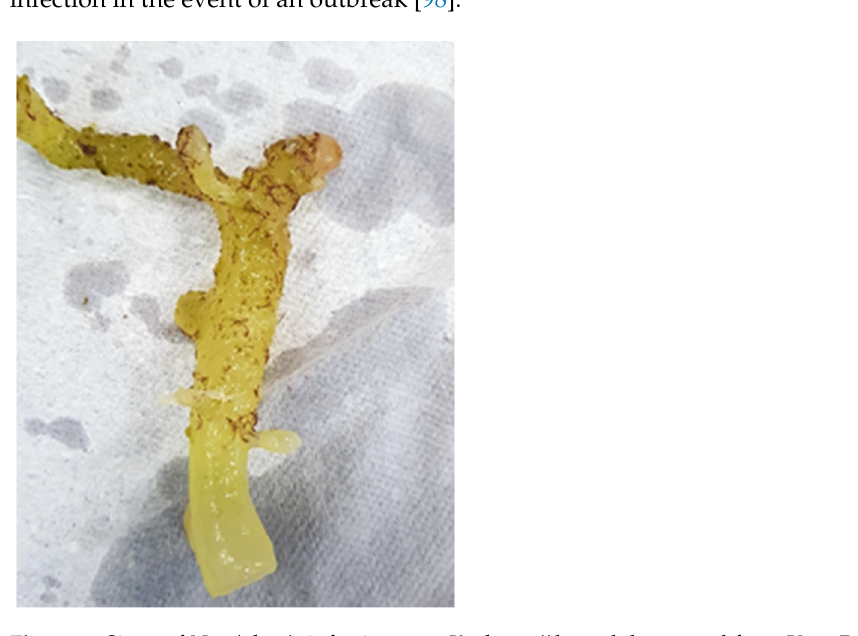
Figure 4. Signs of Neosiphonia infection on a K. alvarezii branch harvested from Kota Belud, Sabah.